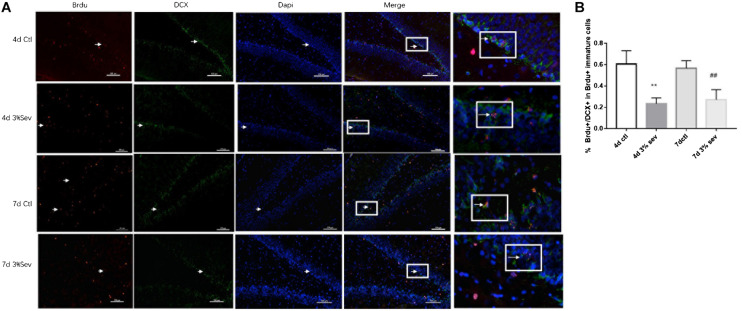
Sevoflurane exposure decreased the differentiation into DCX in BrdU+ immature cells 4 and 7 days after anesthesia. (A) BrdU (red) co-localization with DCX (green) presented the late progenitor cells differentiating into immature cells in the 4 and 7 days in sevoflurane and control groups. Scale bar = 100 μm. (B) Quantification percentage of BrdU+/DCX+ in BrdU+ immature cells. Values are presented as mean ± SD, n = 3; **P < 0.01 compared with the control 4 days group, ##P < 0.01 compared with the control 7 days group. One-way ANOVA with Newman–Keuls post hoc test or Kruskal–Wallis with Dunn’s Multiple comparison test was used for data analysis.